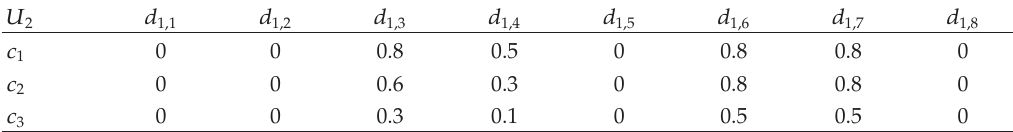
(cid:5) H,D (cid:6) . 1